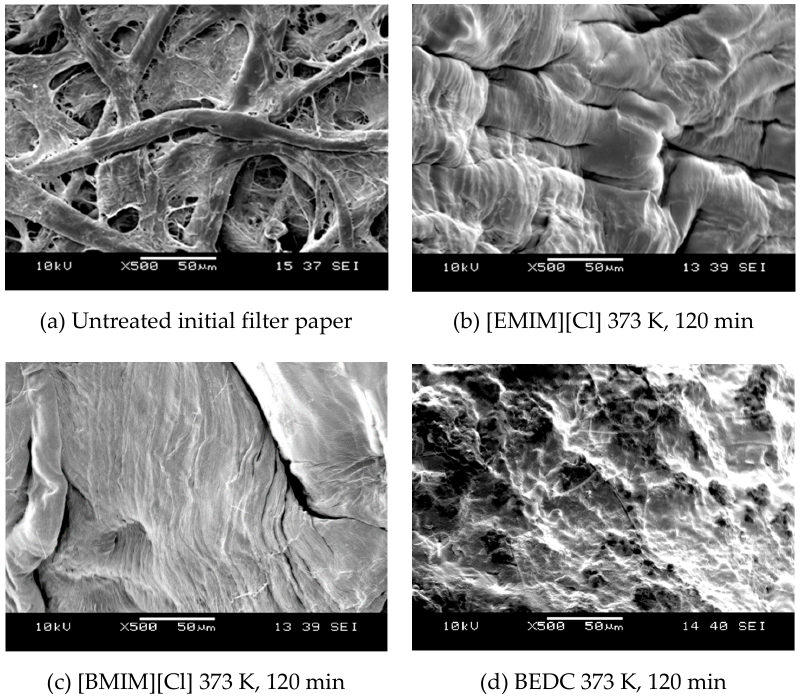
Figure 3. SEM images of filter paper sample, ( a ) untreated, treated with ( b ) [EMIM][Cl], ( c ) [BMIM][Cl] and ( d ) BEDC.